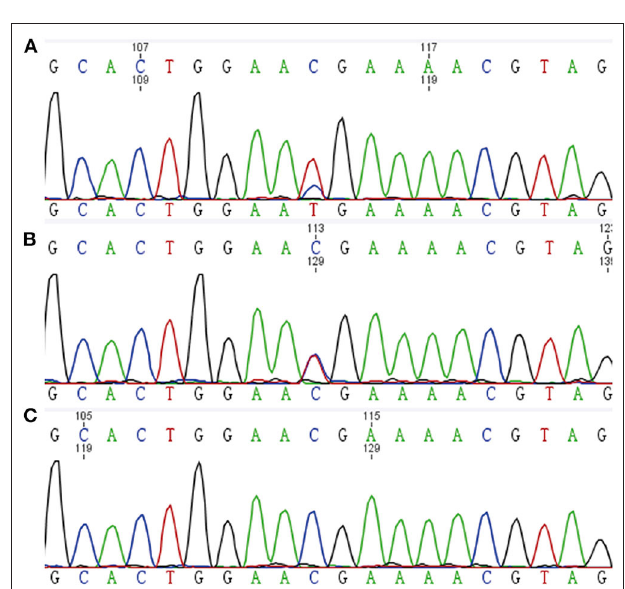
FIGURE 4 | Tumor DNA sequence chromatograms. (A) PCC of the proband. (B) GN of the proband’s son. (C) RET-mutated PCC.